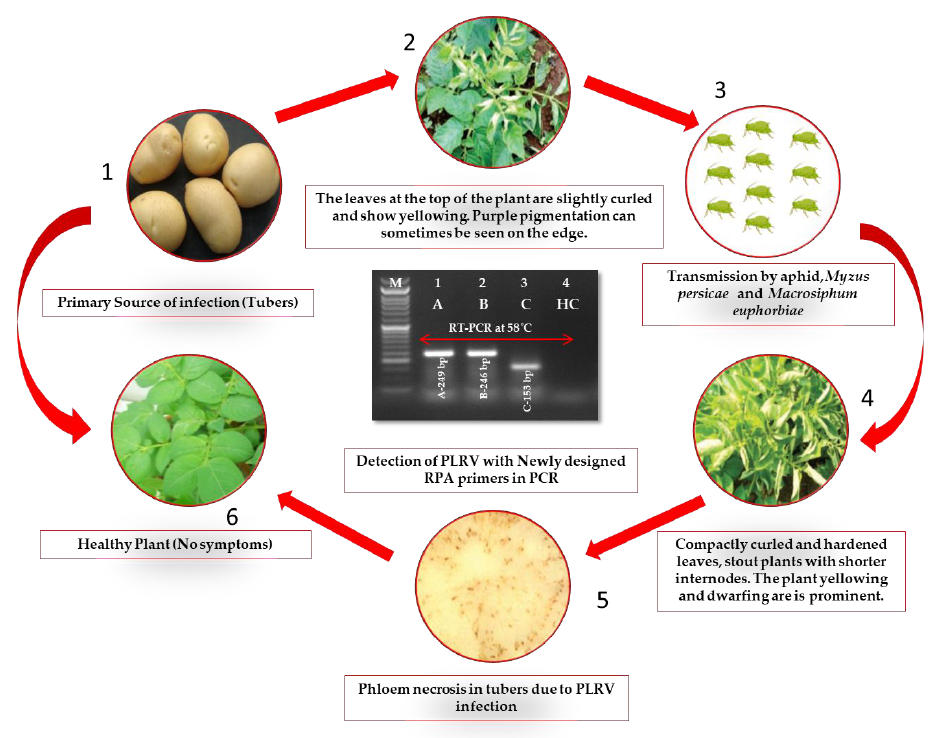
Figure 2. Illustrative model depicting the potato leafroll virus (PLRV) dissemination, symptoms of severe infection in known samples, and subsequent evaluation of virus by reverse transcription- polymerase chain reaction (RT-PCR) via newly designed primer sets in this investigation. Under current experimentation, PLRV symptomatic leaf samples were procured from a pure virus culture maintenance facility at ICAR-Central Potato Research Institute (ICAR-CPRI), Shimla, Himachal Pradesh, India. The cDNA synthesis was executed with 2 µ L of 200–400 ng/ µ L total RNA with subsequent RT-PCR at 58 ◦ C. The gel documentation-generated image denotes standard 100 bp ladder (Lane M), three primers set (LRRPAF1/R1: Lane 1, LRRPAF2/R2: Lane 2 and LRRPAF3/R3: Lane 3), along with the healthy control (Lane 4). The expected amplified products (bp) of 246 bp, 249 bp and 153 bp are also denoted in each lane for respective primers.